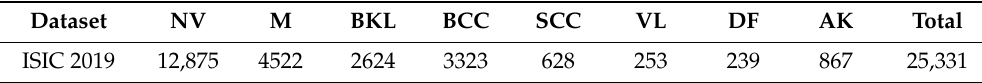
Table 3. Distribution of ISIC 2019 dataset.